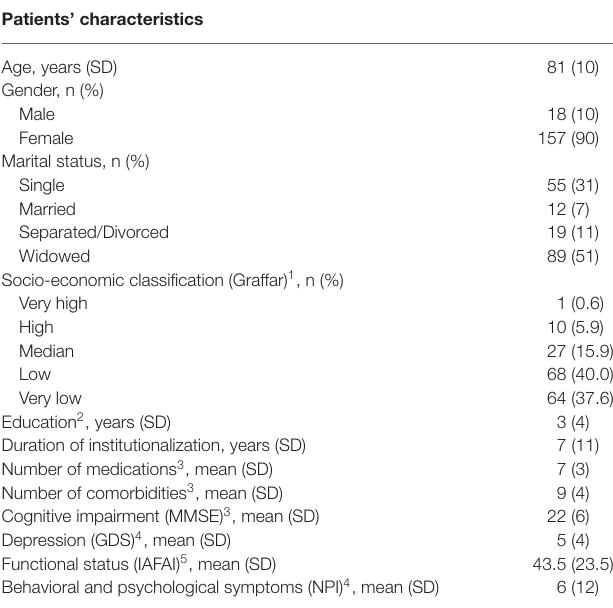
TABLE 1 | Demographic and clinical characteristics of residents